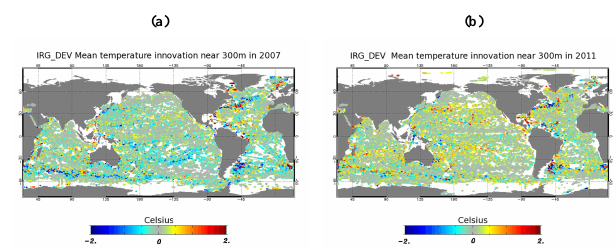
Fig. 26. Mean temperature innovations (°C) near 300 m in 2007 (a) and in 2011 (b) for IRG_DEV system.